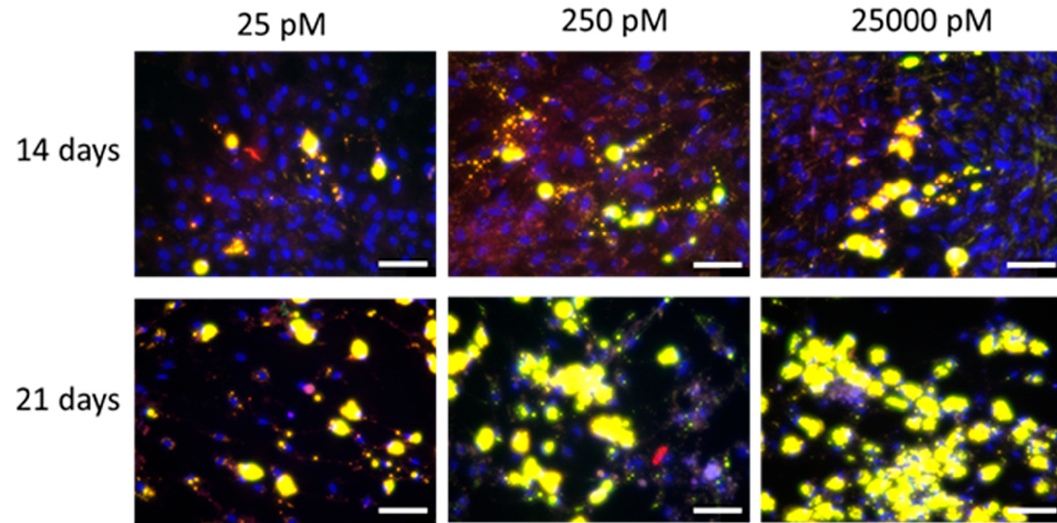
Figure 2. Representative Nile red staining of intracellular lipids in adipocytes after 14 days and 21 days of incubation using various insulin concentrations (25 pM, 250 pM and 25,000 pM) at a physiological magnesium concentration (1 mM). Nile red was imaged for total lipids at 515 nm/590 nm (ex./em.) and coded to red. Non-polar lipids were imaged at 475 nm/570 nm (ex./em.) and coded to green. A green-red overlay results in yellow color for lipid droplets. The blue color represents dsDNA of nuclei stained with DAPI and imaged at 358 nm/461 nm (ex./em.). Scale bar = 100 µm (20× objective).